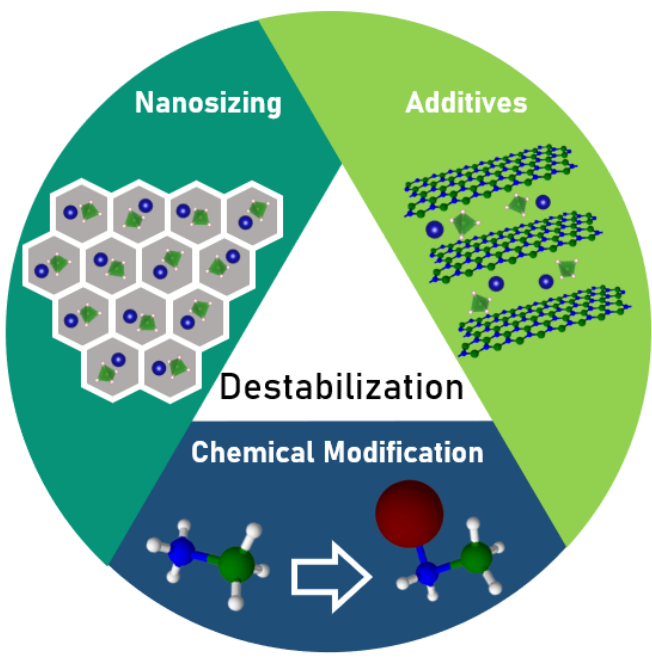
Figure 4. The three destabilization approaches for B-based materials.